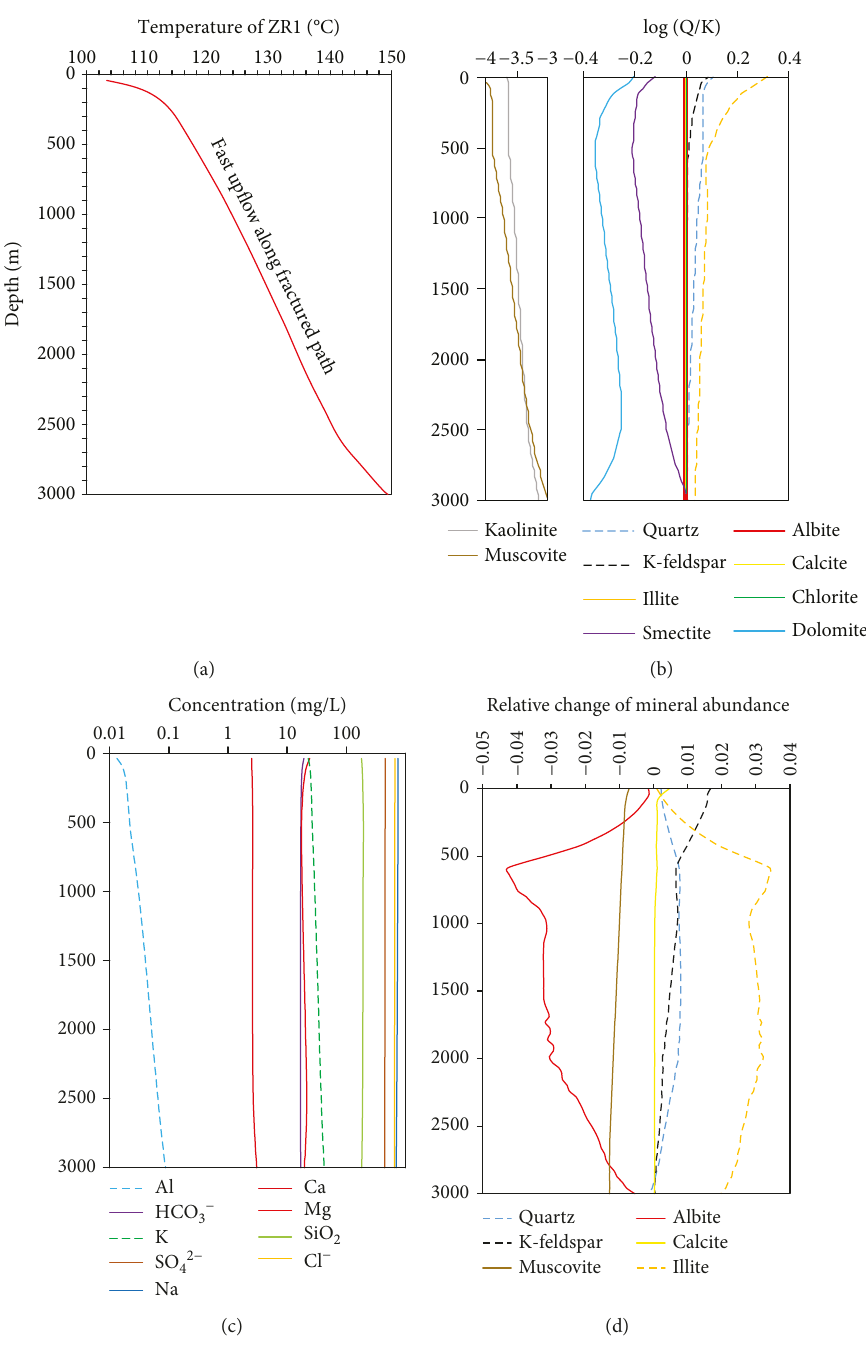
Figure 7: (a) Calculated temperatures along fast up fl ow paths at the position of ZR1, (b) the variation of mineral saturation indices, (c) Na + , K + , Ca 2+ , Mg 2+ , Al 3+ , HCO 3- , Cl - , SO 42- , and SiO concentrations, and (d) mineral abundance. The mineral abundance of kaolinite, chlorite, 2 smectite-Ca, and dolomite maintains unchanged which is not shown in